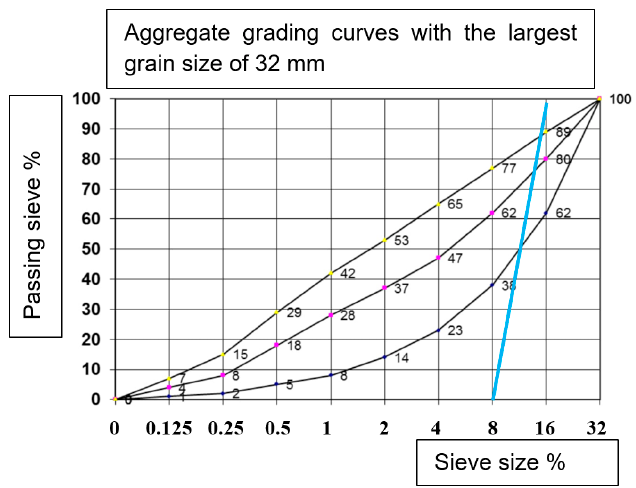
Figure 2. Plotted final gradation curve of technical glass beads—blue line.